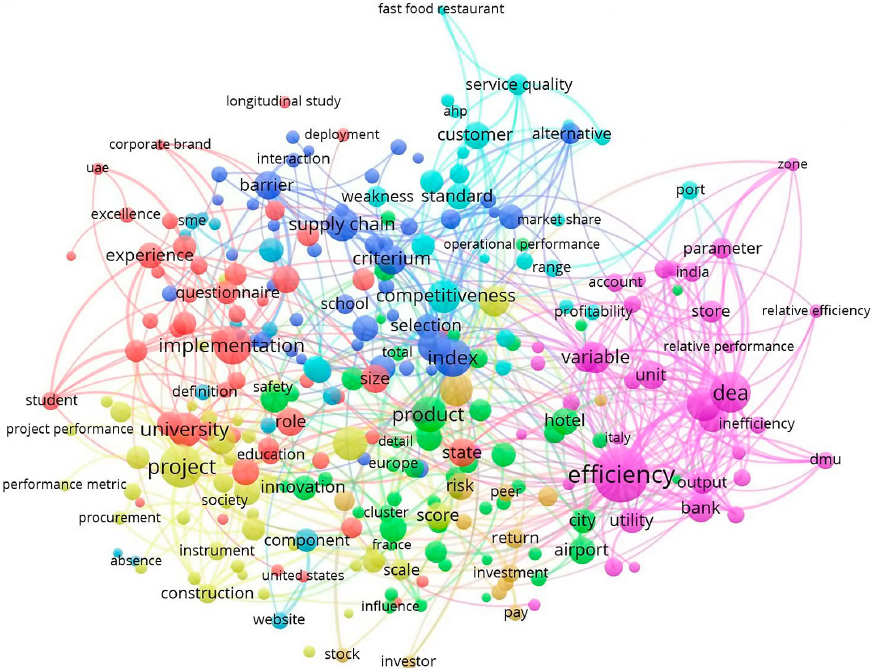
Figure 5. The constructed word co-occurrence network with the words found in the abstracts and topics of the investigations published from 2003–Feb 2020